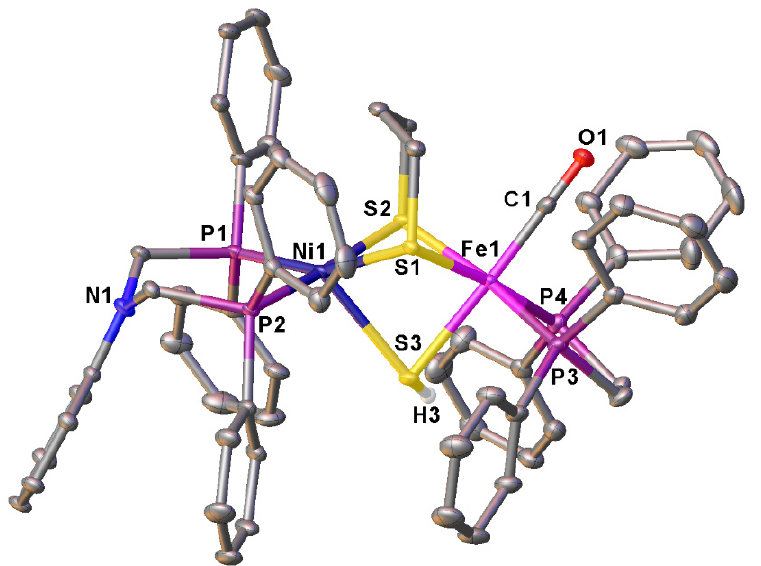
Figure 6. Molecular structure of [ 5 ](BF 4 ) with thermal ellipsoids drawn at a 30% probability level. All H atoms except that on the µ -SH ligand and one BF 4 − anion are omitted for the sake of clarity. Selected bond lengths (Å) and angles ( ◦ ): Ni ···· Fe 3.1002, Ni1-S1 2.2668(10), Ni1-S3 2.5968(9), Fe1-S1 2.2798(9), Fe1-S3 2.3444(9), Fe1-P3 2.2168(10), Fe1-P4 2.2201(10), Ni1-P1 2.1919(10), Ni1-P2 2.2093(9); S1-Ni1-S2 81.12(3), P1-Ni1-S1 159.20(4), P1-Ni1-P2 95.80(4), S1-Fe1-S2 79.76(3), P3-Fe1-S1 93.34(4), P3-Fe1-P4 86.95(4).